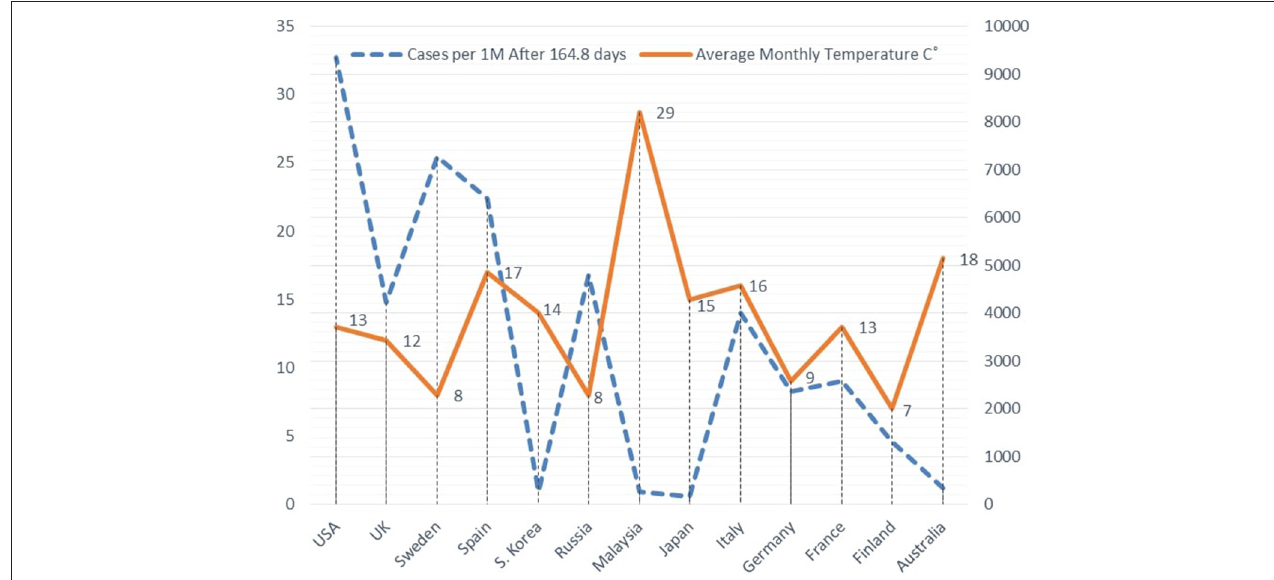
FIGURE 1 | COVID-19 cases per 1M and temperature after 164.8 on average in January group countries.